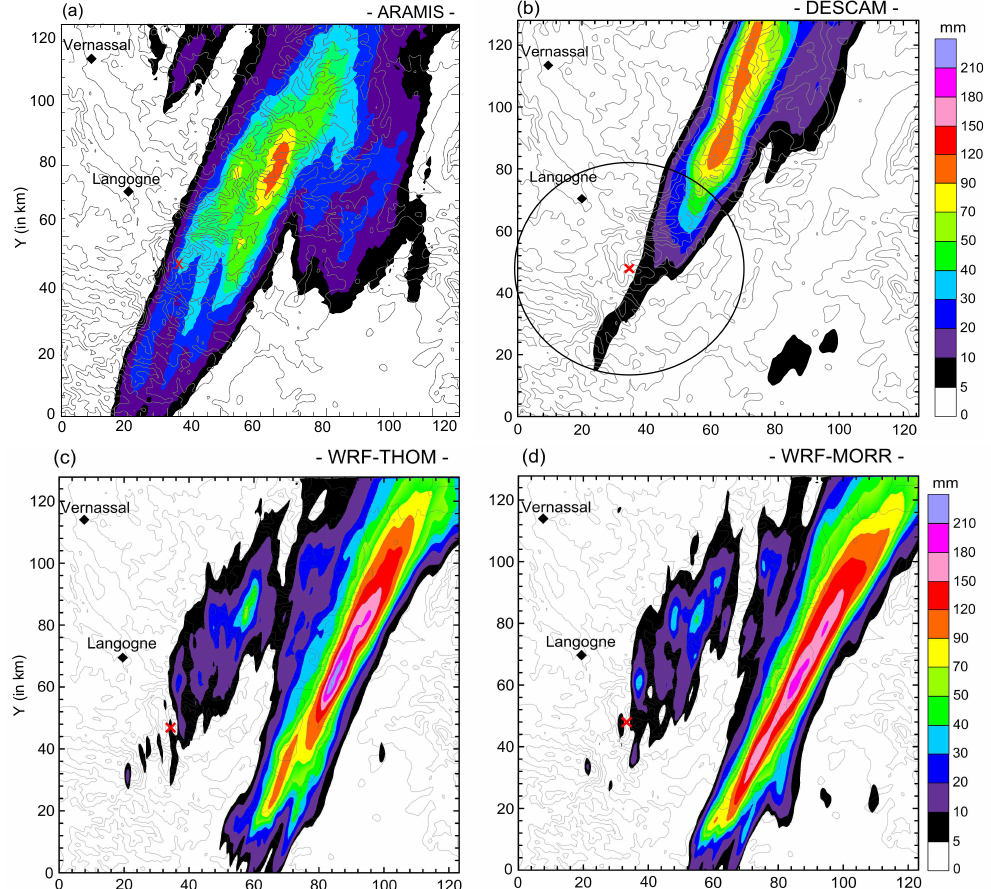
Figure 3. 12-h cumulative rainfall retrieved from the ARAMIS radar network ( a ) and simulated with DESCAM ( b ), WRF-THOM ( c ) and WRF-MORR ( d ) for the innermost domain. The red cross and the black circle show, respectively, the location of the X-band radar and its observed area. The topography is represented from sea level to 2400 m height every 200